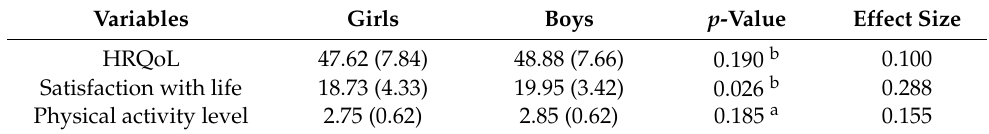
Table 2. Differences between girls and boys in HRQoL, satisfaction with life, and physical activity